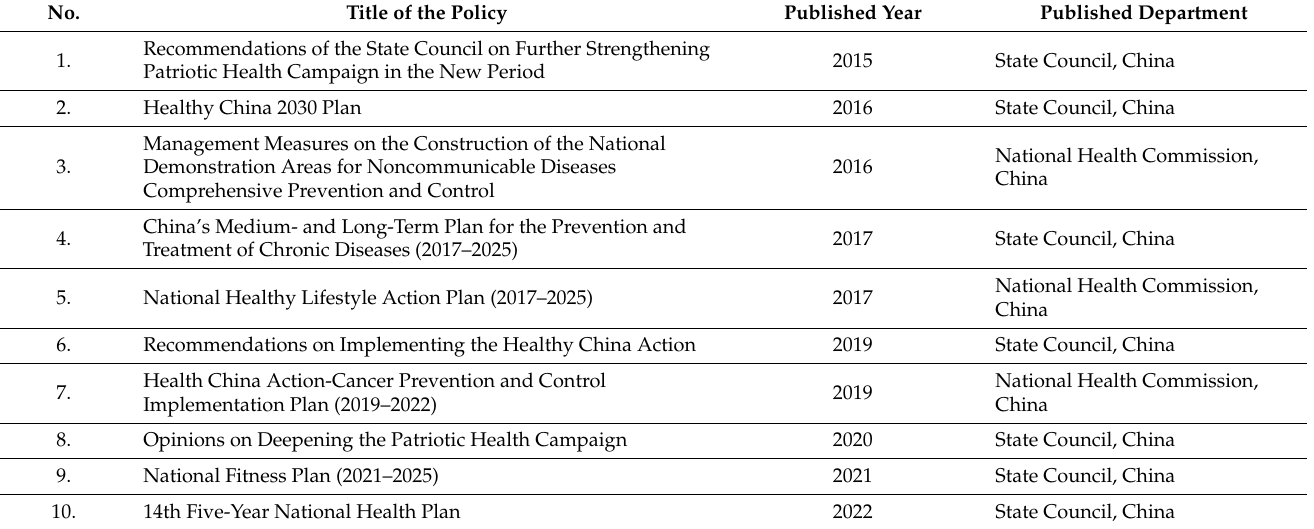
Figure 2. The number and issued year of NCD prevention policies in China. Table 1. Overview of the policies for NCD control and prevention developed with the health promotion concept.